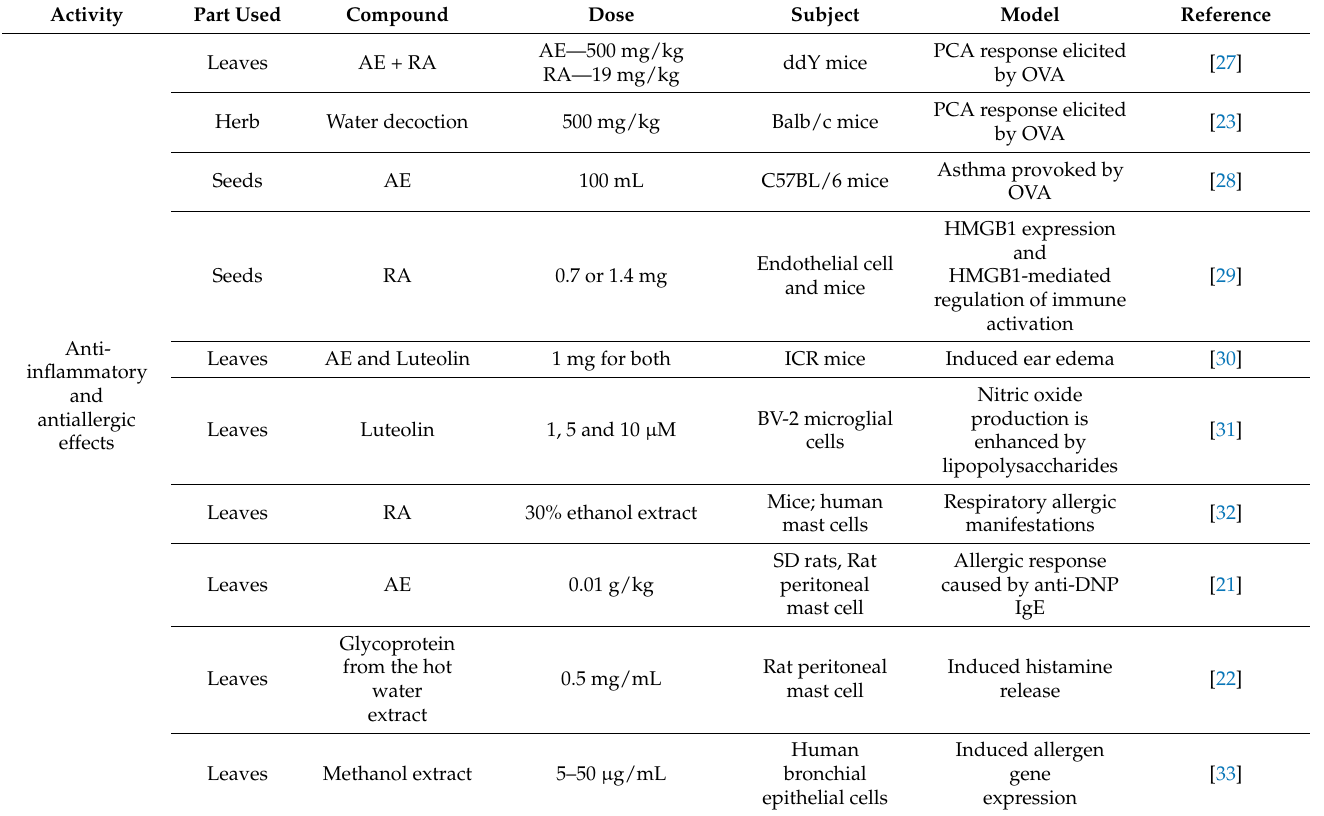
Table 1. Summary of evidence from in vitro and animal studies regarding the Perilla frutescens